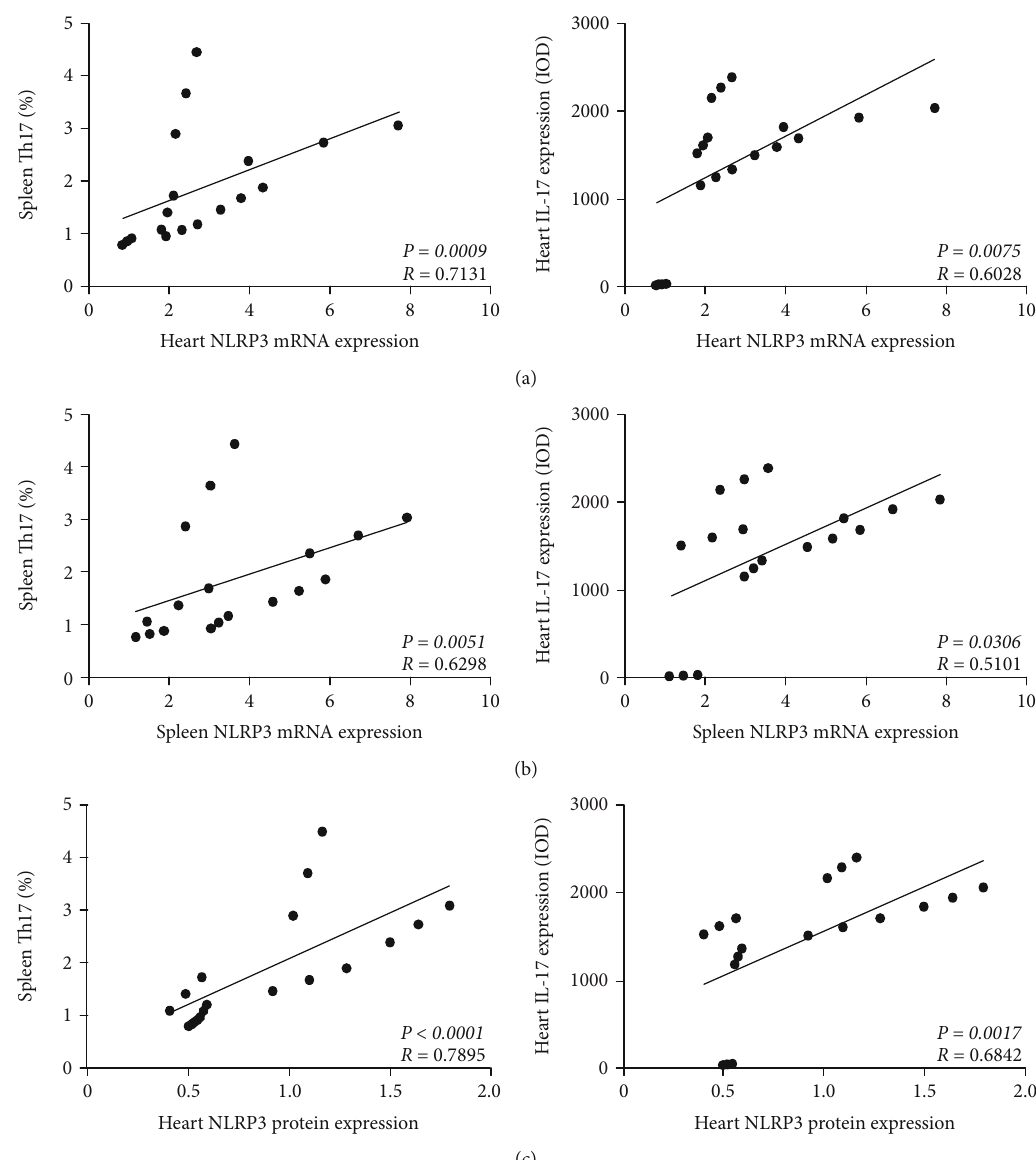
Figure 4: Correlation analysis of NLRP3 in fl ammasome and Th17 cells. (a) Correlation analysis between NLRP3 (mRNA level in the heart) and Th17 cells (proportion in the spleen, left) or IL-17 expression (IOD score detected by IHC in heart, right). (b) Correlation analysis between NLRP3 (mRNA level in the spleen) and Th17 cells (proportion in the spleen, left) or IL-17 expression (IOD score detected by IHC in the heart, right). (c) Correlation analysis between NLRP3 (protein level in the heart) and Th17 cells (proportion in the spleen, left) or IL-17 expression (IOD score detected by IHC in the heart, right). P : P value; R : Spearman R